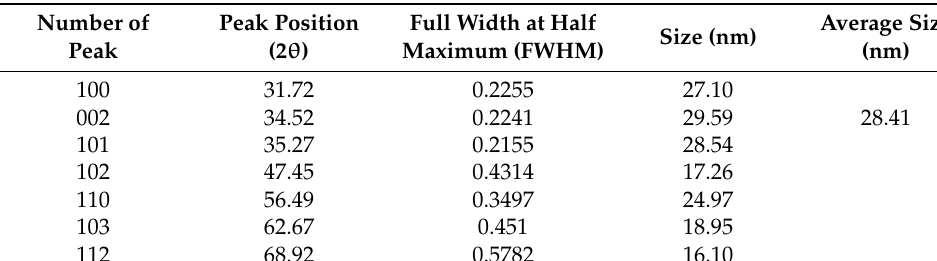
Table 2. The crystallite sizes of GL–CMC–ZnO NCs using XRD analysis.